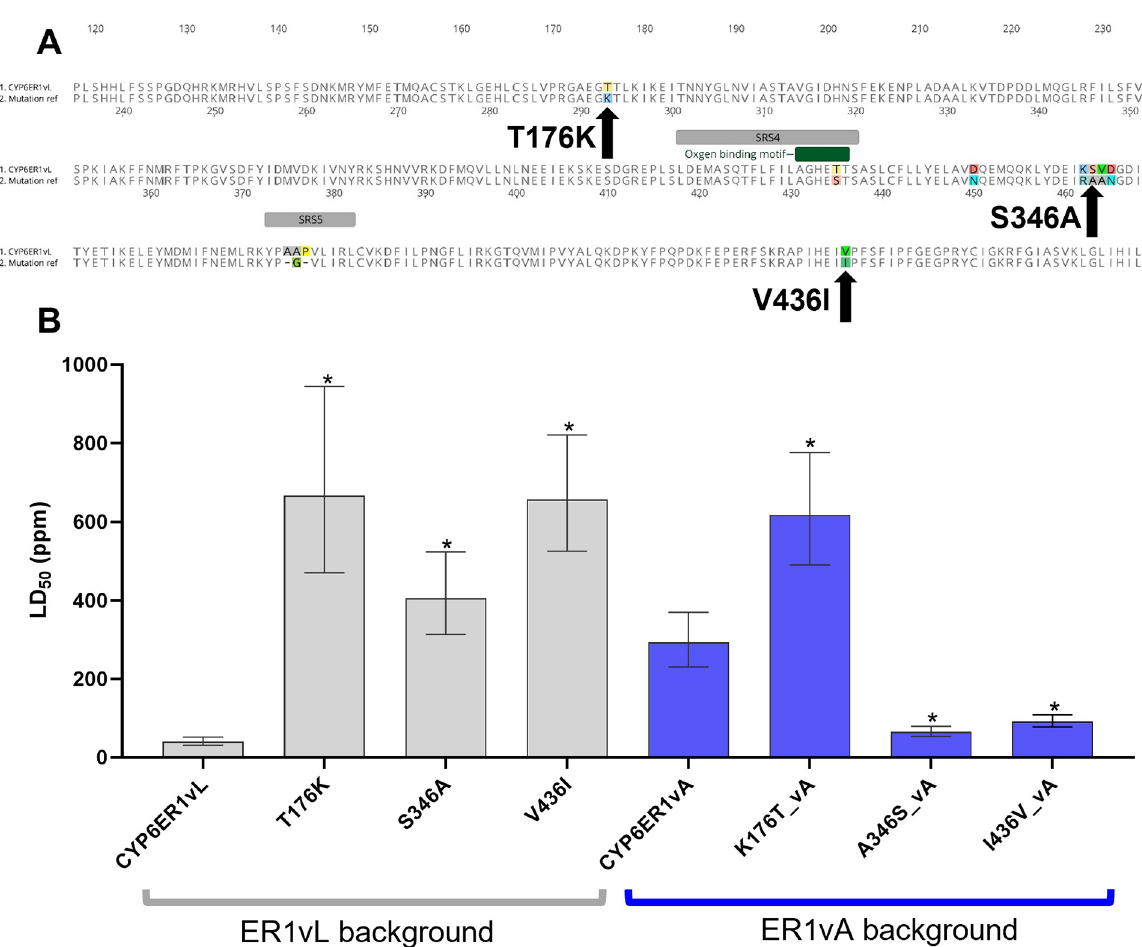
Fig 4. Sensitivity of transgenic strains of Drosophila melanogaster expressing mutated CYP6ER1 variants to ethiprole. A) Amino acid alignment of CYP6ER1vL and a notional CYP6ER1 sequence displaying the nature and position of three mutations found in CYP6ER1vA outside of SRS4 and SRS5. B) Lethal Concentration 50% (LC 50 ) values derived from full dose-response bioassays are displayed for D . melanogaster strains expressing CYP6ER1vL variants to which three mutations found in CYP6ER1vA outside of SRS4 and SRS5 were added, or CYP6ER1vA to which the three mutations were removed. For comparison LC 50 values derived from flies expressing the wildtype versions of CYP6ER1vA and CYP6ER1vL are shown. Error bars show 95% CI (n = 4). Significant differences (p = < 0.05) in LC 50 values of fly lines expressing CYP6ER1 mutated variants and the respective wildtype fly line (CYP6ER1vA or CYP6ER1vL), identified by z- tests using the compParm() function of the ’drc’ package [36], are indicated using an asterisk above relevant bars. See also S6 Table.